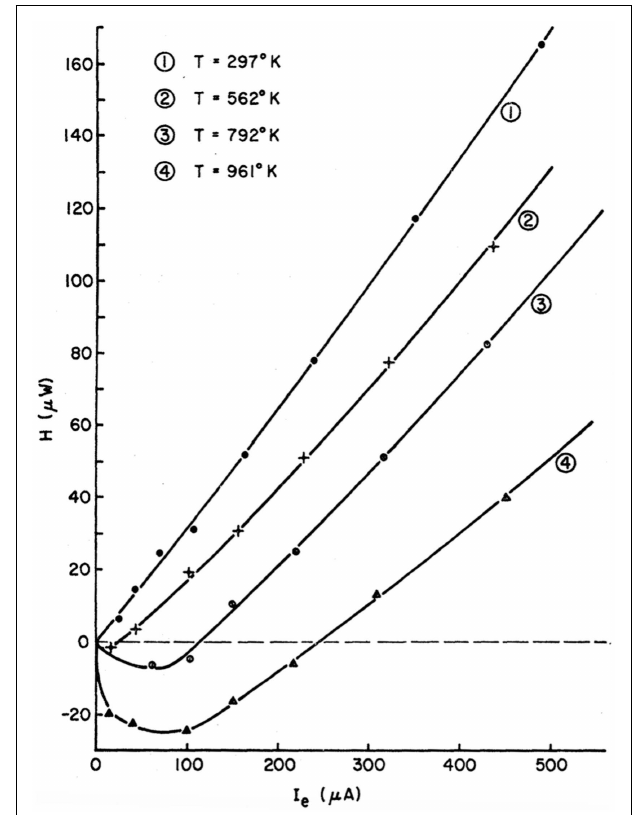
FIGURE 12 | Net energy exchange H leaving a tungsten tip at a variety of temperatures as a function of field-emission current . Reprinted with permission from Swanson et al.